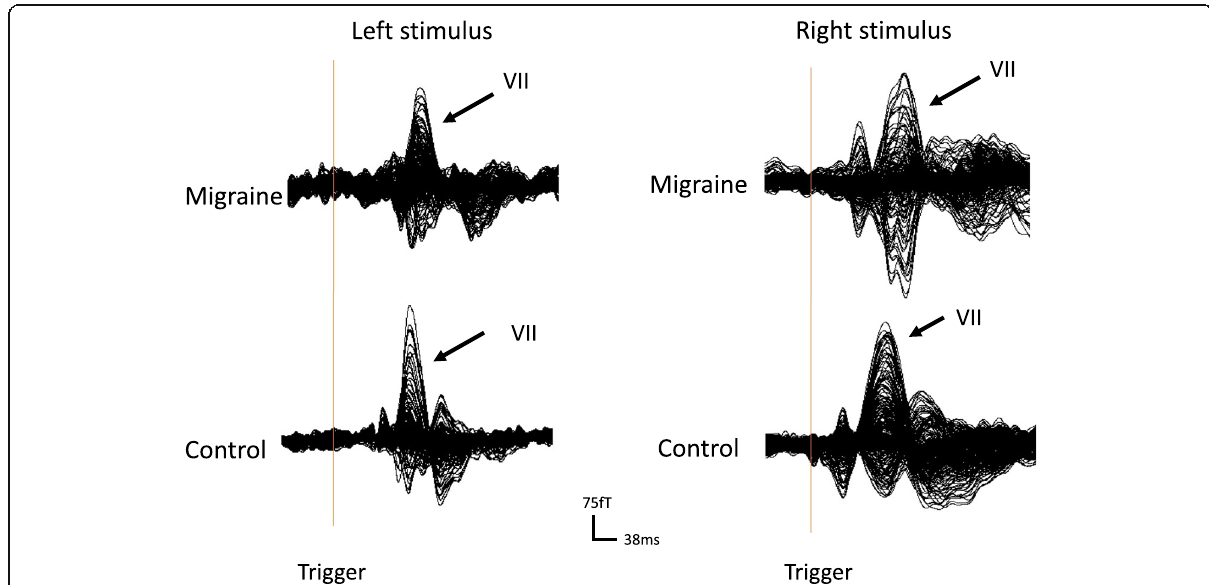
Fig. 1 Morphology of waveform of visual-evoked magnetic fields (VEFs) Magnetoencephalography waveforms showing neuromagnetic activation evoked by the visual stimulus (left and right half fields) in a migraine subject ( ‘ Migraine ’ ) and a healthy subject ( ‘ HC ’ ) in a frequency band of 5 – 100Hz. There are at least three responses in the visual-evoked magnetic fields (VEFs), respectively “ VI ” , “ VII ” and “ VIII ” . In our study, VII as our observational object. There are differences in morphology of the VII waveforms between migraine subjects and controls. The latencies of the VII in migraine subjects are prolonged when compared with those in the controls. The “ Trigger ” indicates the start of a visual